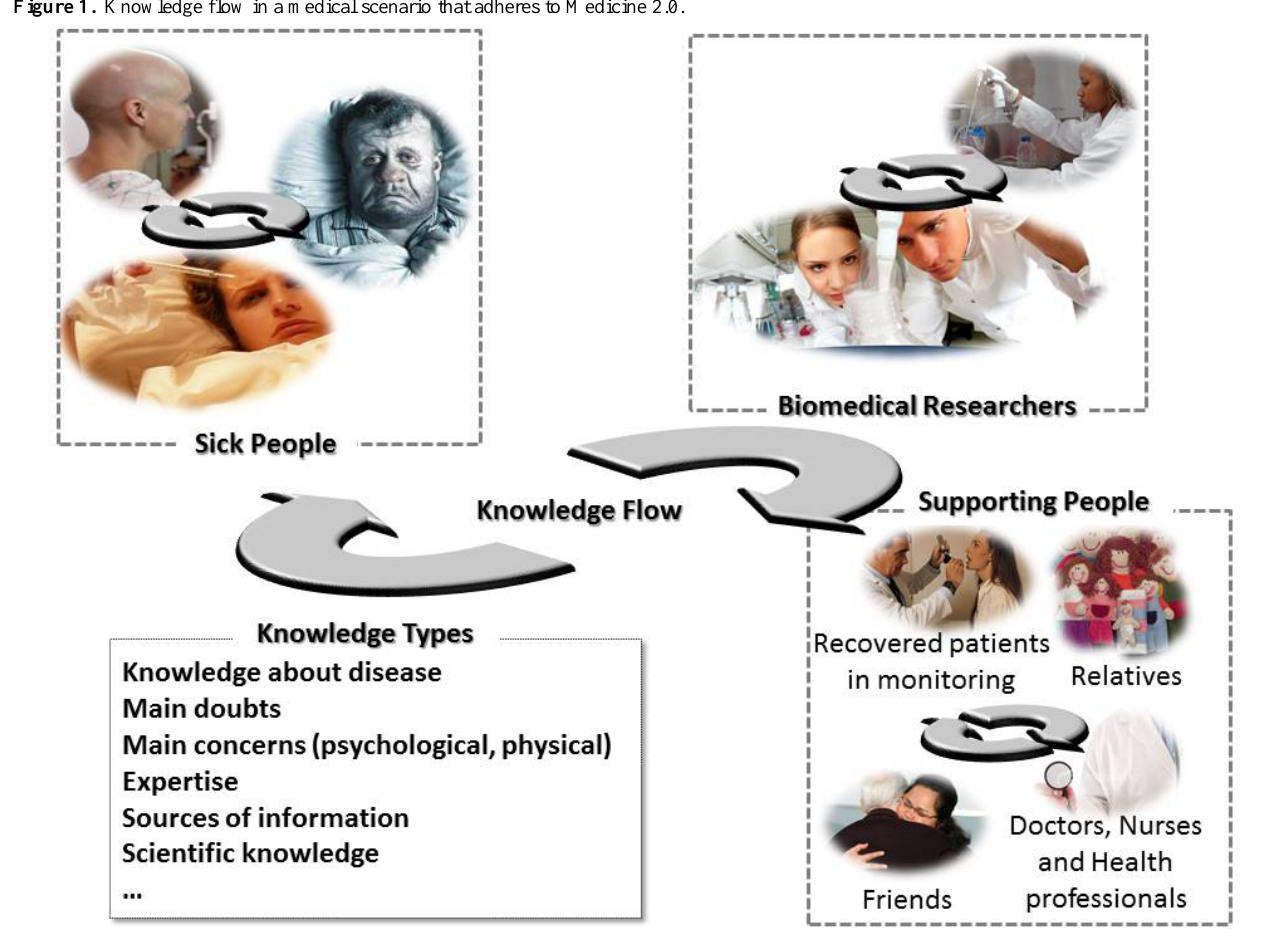
Figure 1. Knowledge flow in a medical scenario that adheres to Medicine